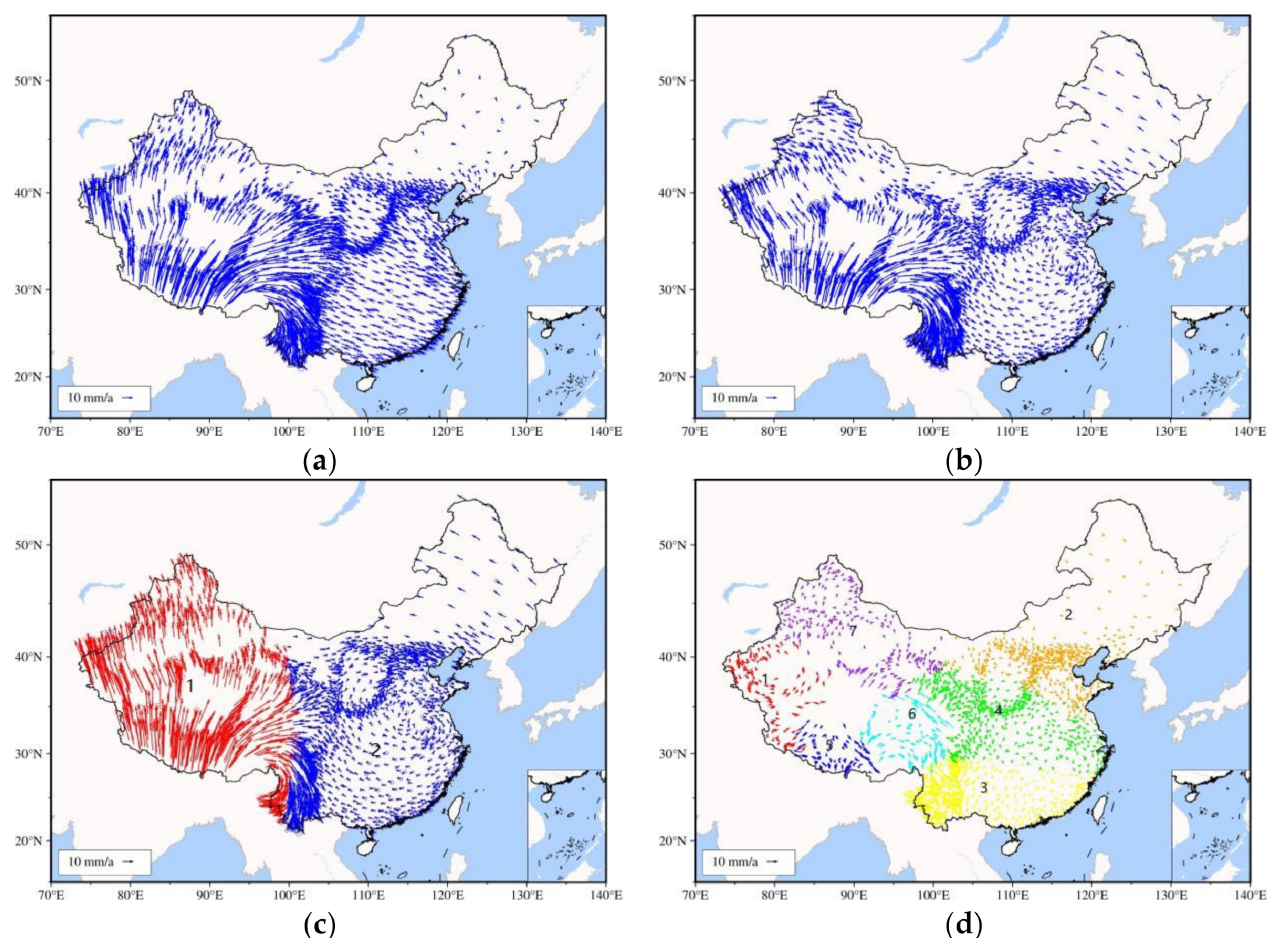
Figure 13. The horizontal relative velocity of different blocks (The different colors represent different blocks in ( c , d )). ( a ) Eurasian block. ( b ) China block 1. ( c ) China block 2. ( d ) China block